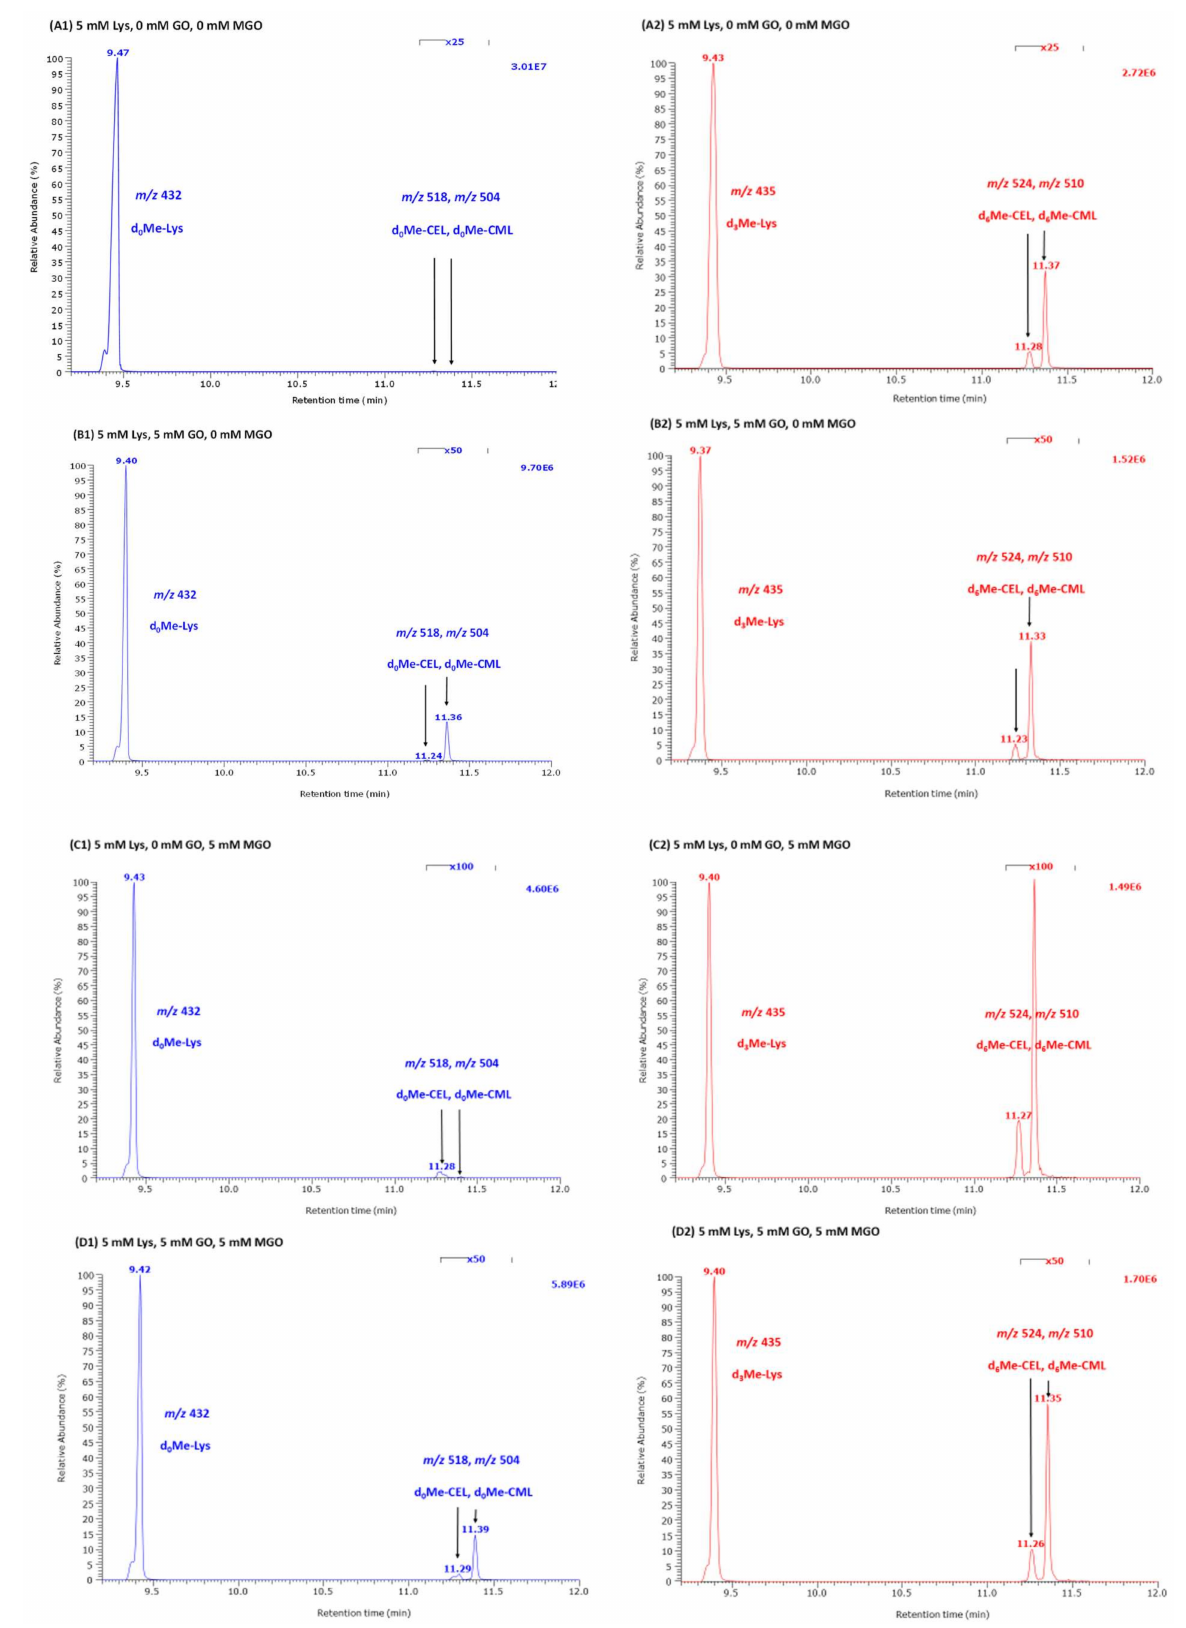
Figure 2. Representative partial GC-MS chromatograms from the reaction mixtures of Lys with GO, MGO and their mixture in 100 mM phosphate buffer, pH 7.4, for 1 min at room temperature. ( A ) Lys (5